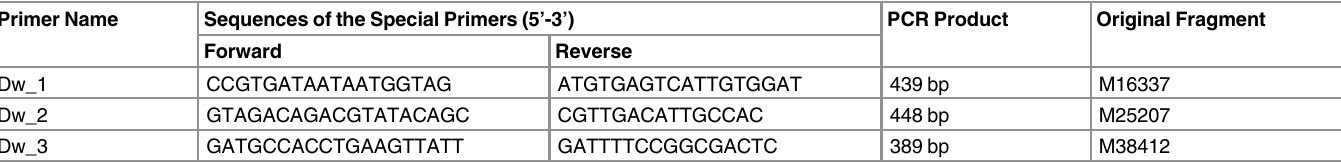
Table 4. Primer sequences of the specific molecular markers used in the Sanger